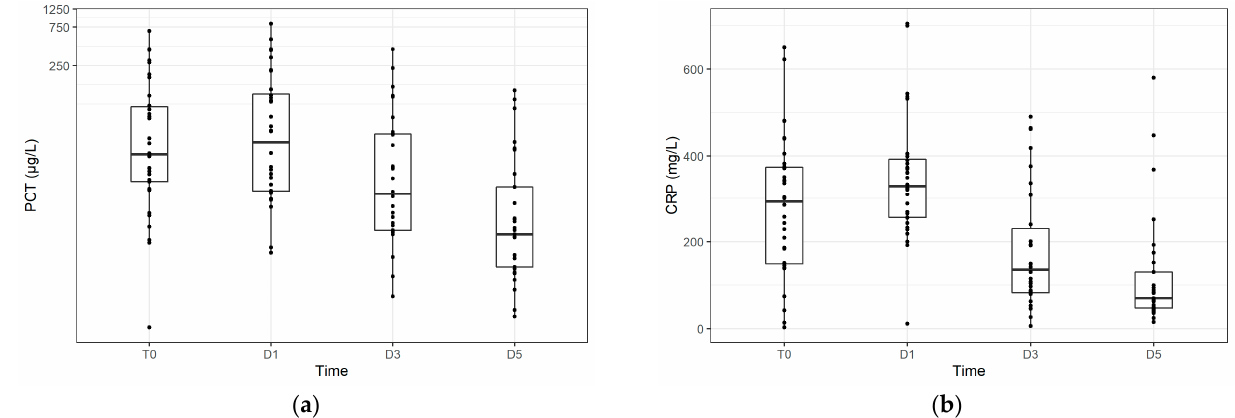
Figure 4. Serum concentrations of procalcitonin ( a ) and C-reactive protein ( b ) at individual times.